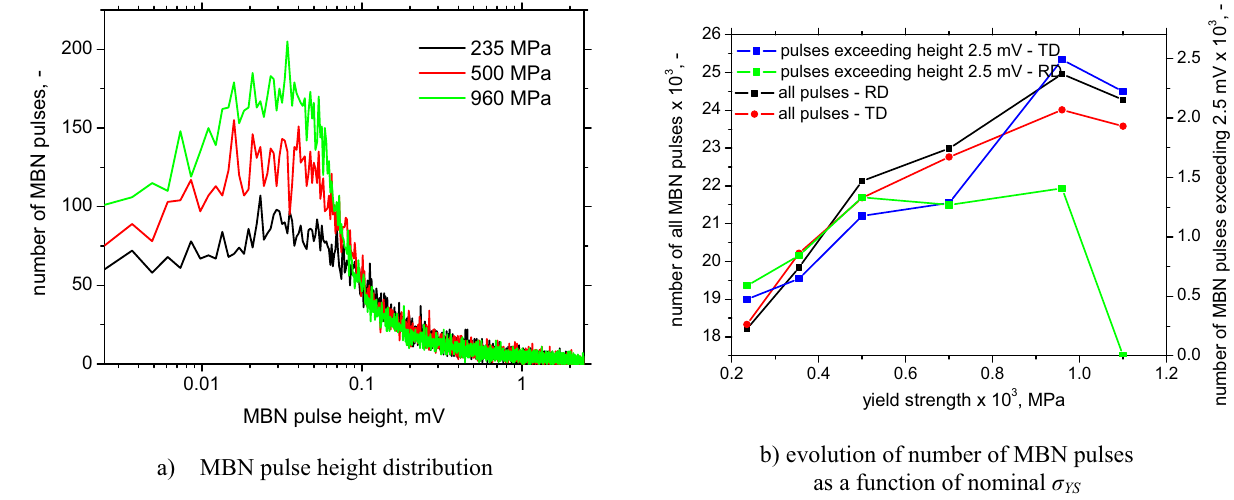
Figure 12. MBN pulse height distribution and evolution of number of MBN pulses.